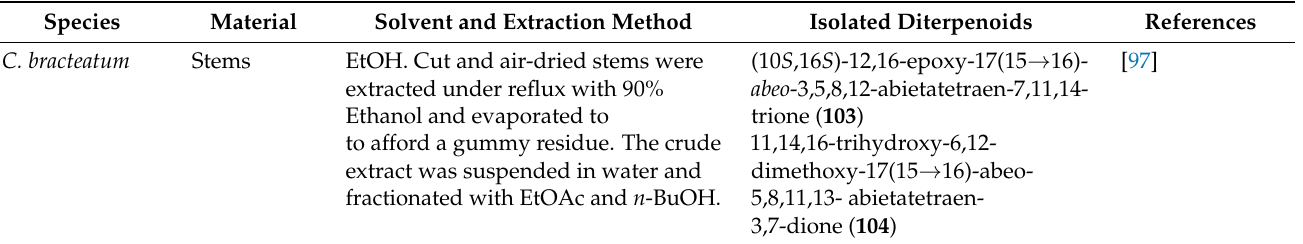
Table 12. The diterpenoid extraction methods and Clerodendrum bracteatum plant materials for diterpenoid